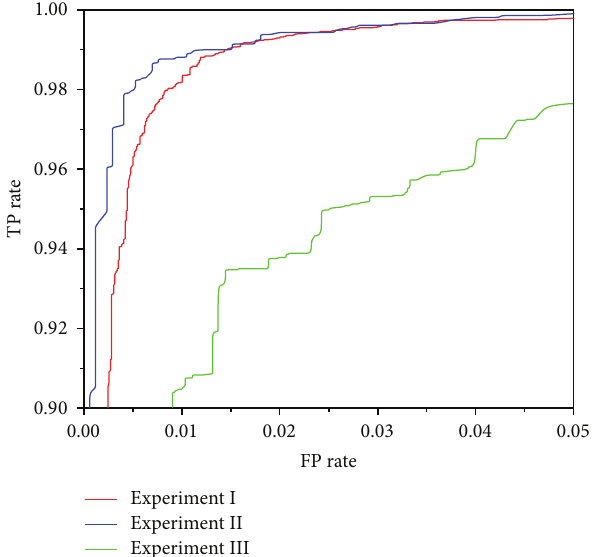
Figure 7: ROC curves for random forest (wrapper) classification